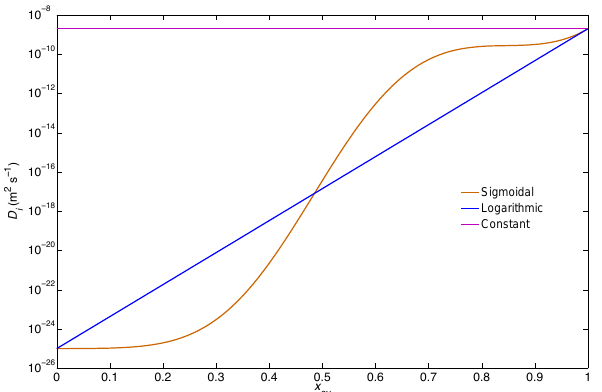
Figure 2. Example dependencies of D i on the mole fraction of the semi-volatile component. For the constant case both compo- nents have a value of 2 × 10 − 9 m 2 s − 1 and for the other cases the self-diffusion coefficient of the semi-volatile component is set to 2 × 10 − 9 m 2 s − 1 and that of the non-volatile is 1 × 10 − 25 m 2 s − 1